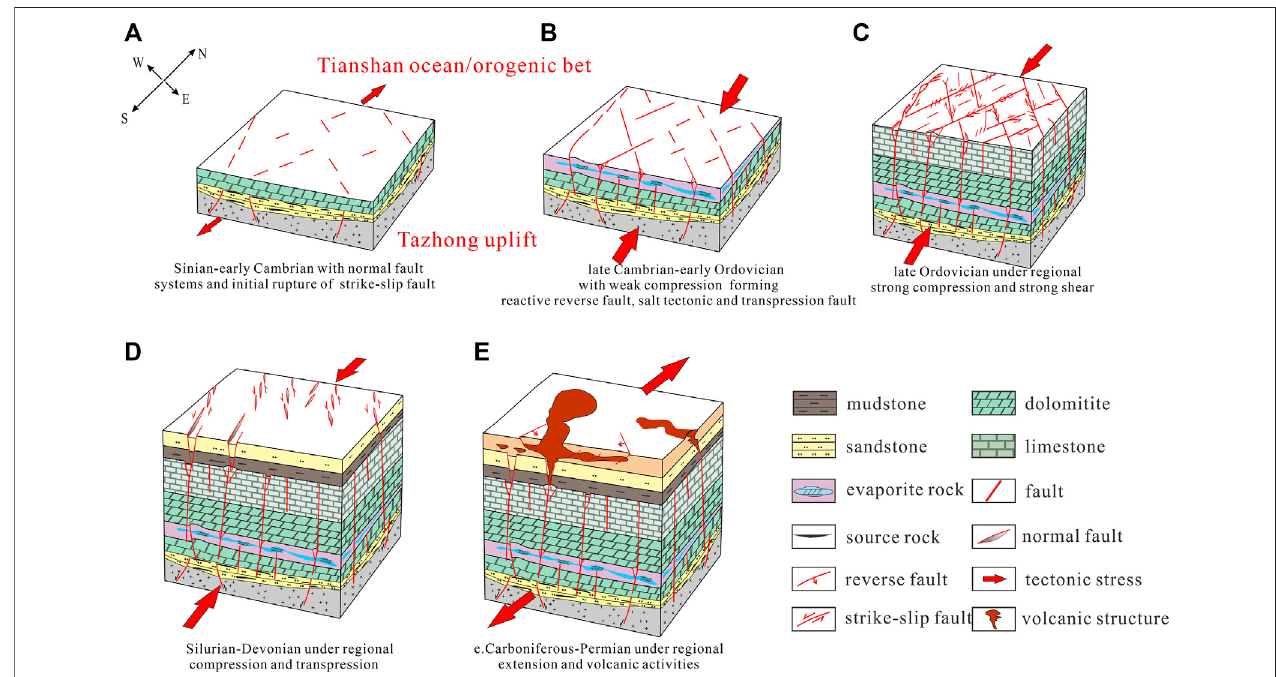
FIGURE 15 | Evolution model of the strike-slip fault system of the Tabei uplift: (A) fault evolution stage in the Sinian – Early Cambrian, (B) fault evolution stage in the Late Cambrian – Early Ordovician, (C) fault evolution stage in the Late Ordovician, (D) fault evolution stage in the Silurian – Devonian, and (E) fault evolution stage in the Carboniferous –